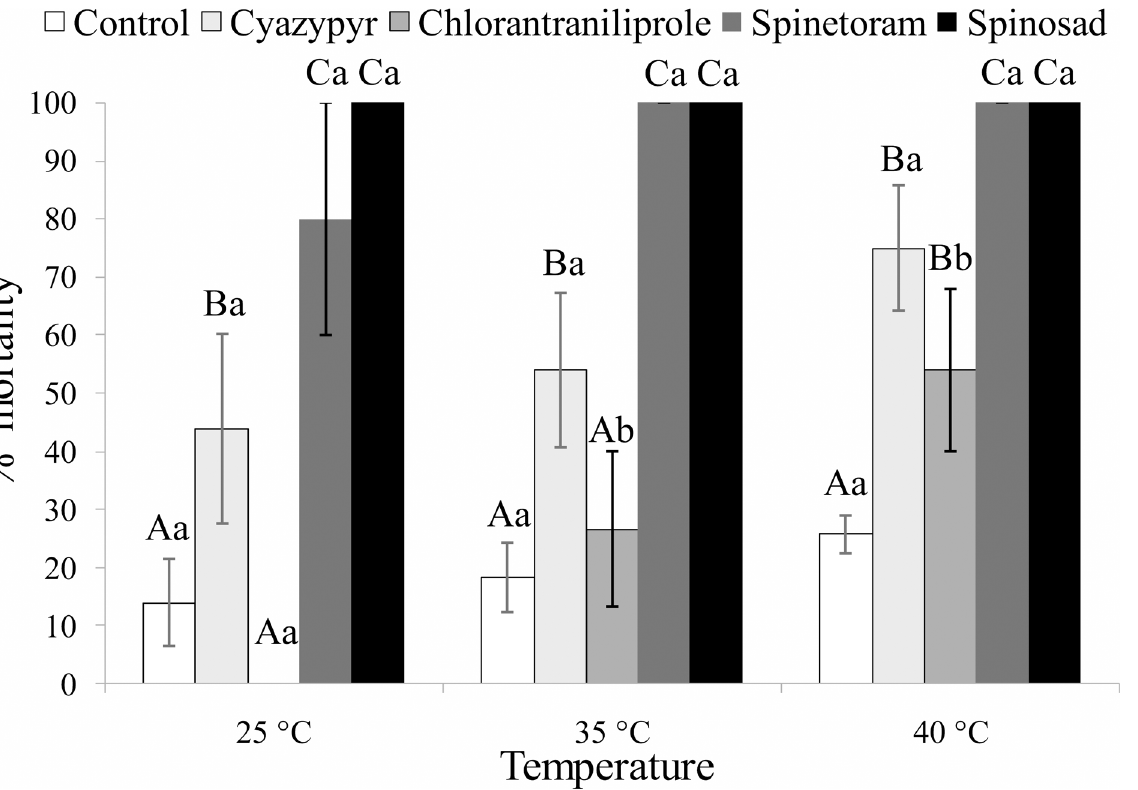
Fig 1. Lethal effects. Mean percentages ( ± SEM) of survival of Bracon nigricans adults when exposed for three days to insecticide residues at three constant temperatures. Columns bearing the same letter (upper case letters: within the same temperature regime; lower case letters: within the same tested insecticide) are not significantly different ( P > 0.05; ANOVA with LSD post hoc test for multiple comparisons).